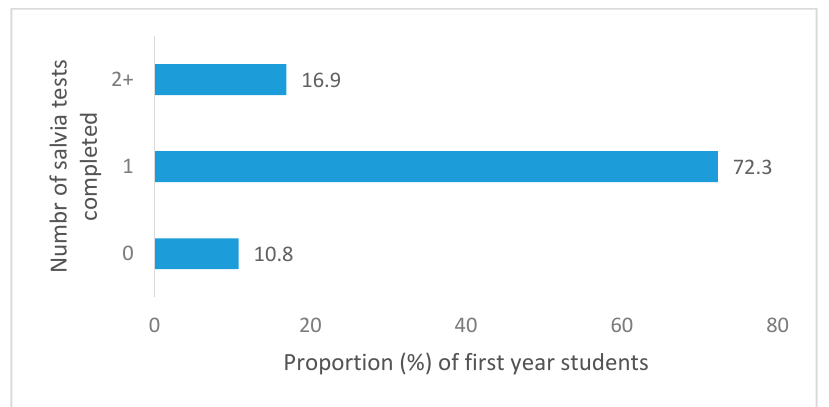
Figure 3. Proportion of year one students completing between 0–2+ saliva tests during P-ATS.